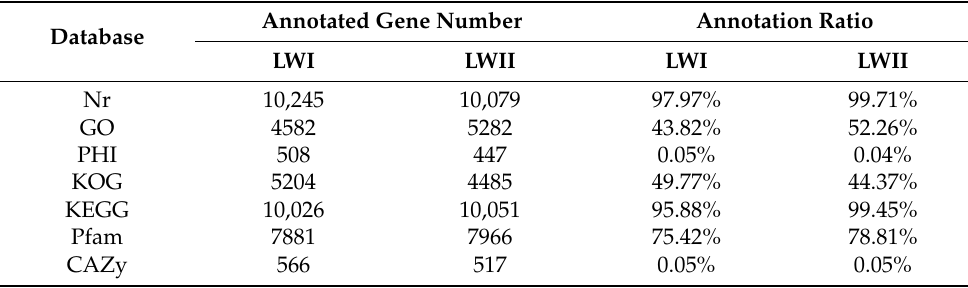
Table 2. Statistics of E. rostratum LWI and B. zeicola LWII gene